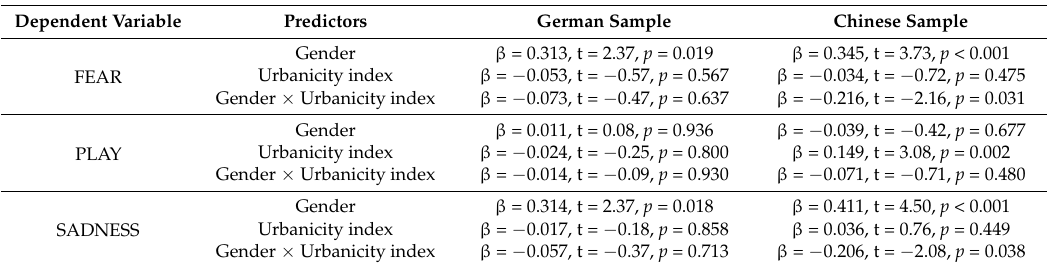
Table 5. Standardized regression coefficients for the regression analysis to explain the score in the PETS FEAR/PLAY/SADNESS.